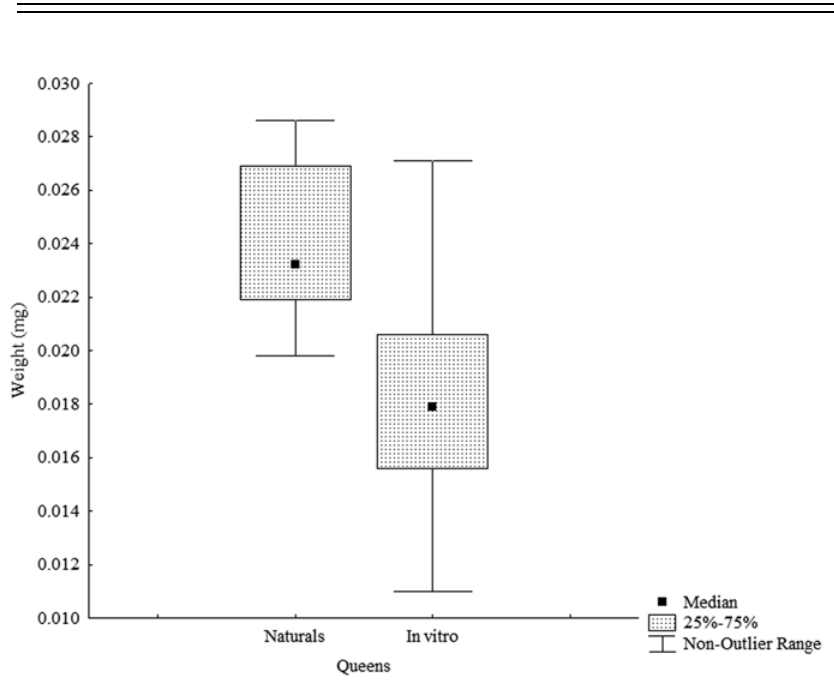
Fig. 4. Comparison of the weight (mg) of the virgin queens of Frieseomelitta varia produced under natural conditions (n=6) and in vitro